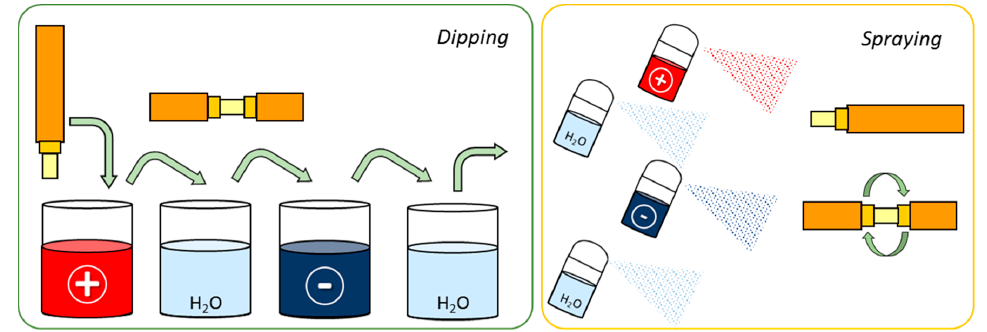
Figure 10. LbL nanoassembly applied for optical fibre (reflection or transmission configurations) by dipping (image on the left hand side) and by spraying (image on the right hand side).